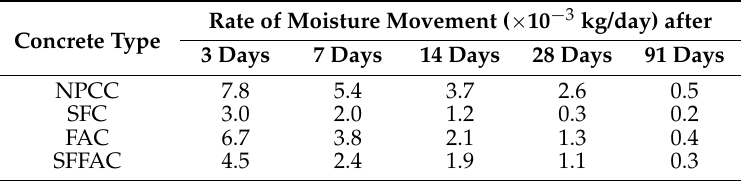
Table 4. Moisture movement into different